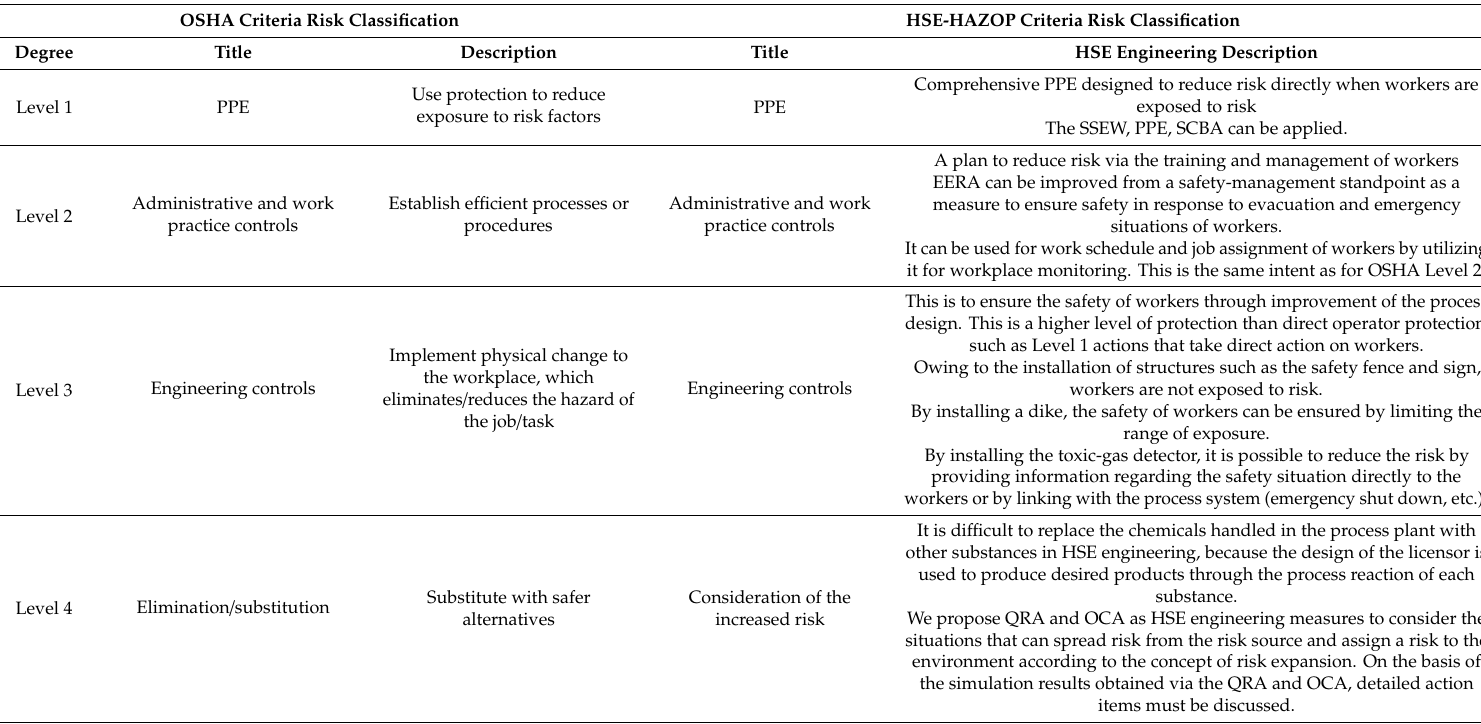
Table 11. Comparison between the OSHA criteria risk classification and HSE-HAZOP criteria risk